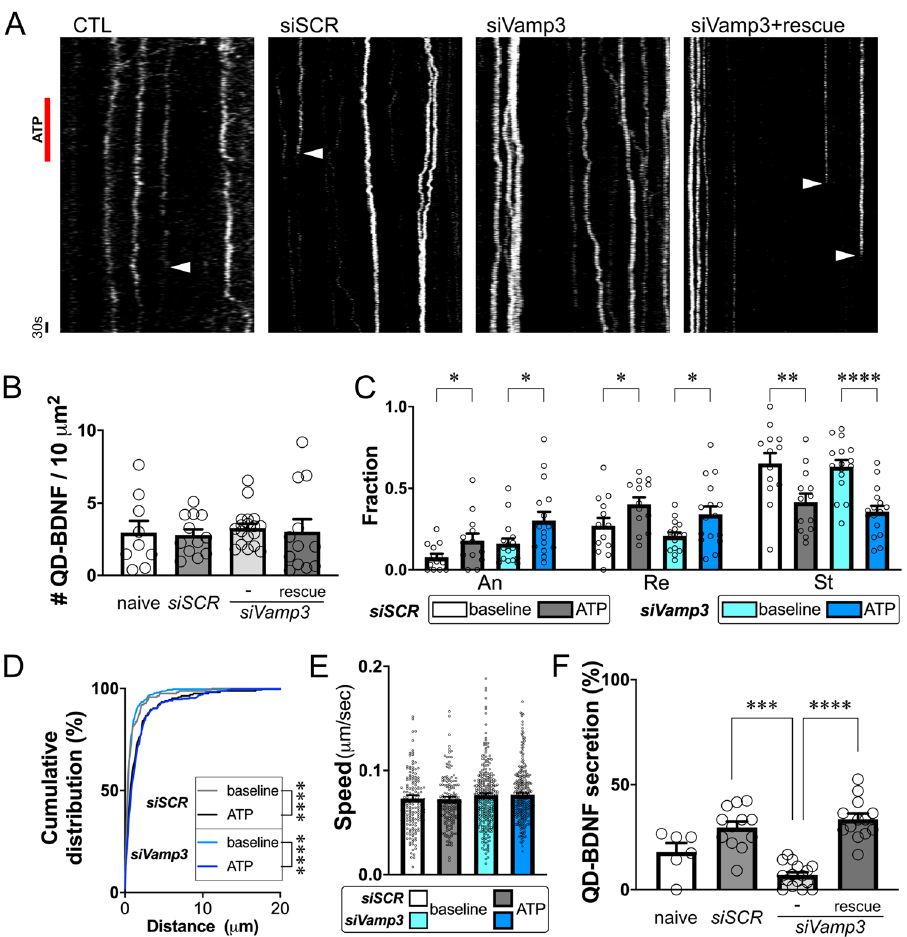
Figure 5. Vamp3 is necessary for ATP-induced endocytic BDNF secretion. (A) Representative QD-BDNF kymographs generated by using ImageJ/FIJI software (Ver. 2.1.0/1.53c, NIH), from astrocytes with GFP- (CTL), siSCR -, siVamp3 -, or siVamp3 + human Vamp3 ( siVamp3 + rescue). White arrowheads: disappearance of QD-BDNF particles. ( B) Average intracellular QD-BDNF densities under each condition. N = 9–18 cells. The quantification of QD-BDNF particle numbers was determined by using ImageJ/FIJI software (Ver. 2.1.0/1.53c, NIH). ( C) Average QD-BDNF fractions showing immobility (St) or anterograde (An)/retrograde (Re) transport. * P < 0.05, ** P < 0.01, **** P < 0.0001. N = 10–16 cells. ( D) Cumulative distributions of the QD-BDNF transport distances at baseline and after ATP stimulation (ATP) in each group. **** P < 0.0001. ( E) Average velocities of QD-BDNF transport. N = 165 and 302 particles for the siSCR and siVamp3 groups, respectively. F. Average percentages of QD-BDNF secretion events after the indicated treatments. ** P < 0.01, *** P < 0.001, **** P < 0.0001. N of tested cells (with QD particle number): naïve = 6 (102), siSCR = 12 (197), siVamp3 = 16 (304), siVamp3 + rescue = 13